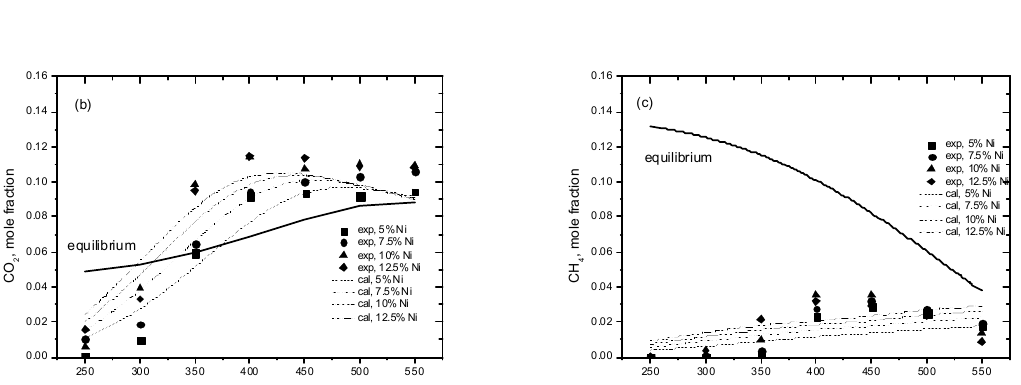
Figure 15. Comparison of experimental (symbols) and numerically predicted (lines) concentrations for WGS as a function of temperature: ( a ) CO, ( b ) CO 2 , ( c ) CH 4 (feed stream—0.1429 CO + 0.2857 H 2 O + 0.2857 H 2 in N 2 ).